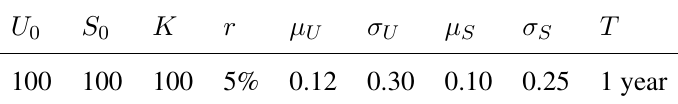
Table 1. Model parameters employed by the hedge simulations (the same parameters as used by Monoyios [5]).